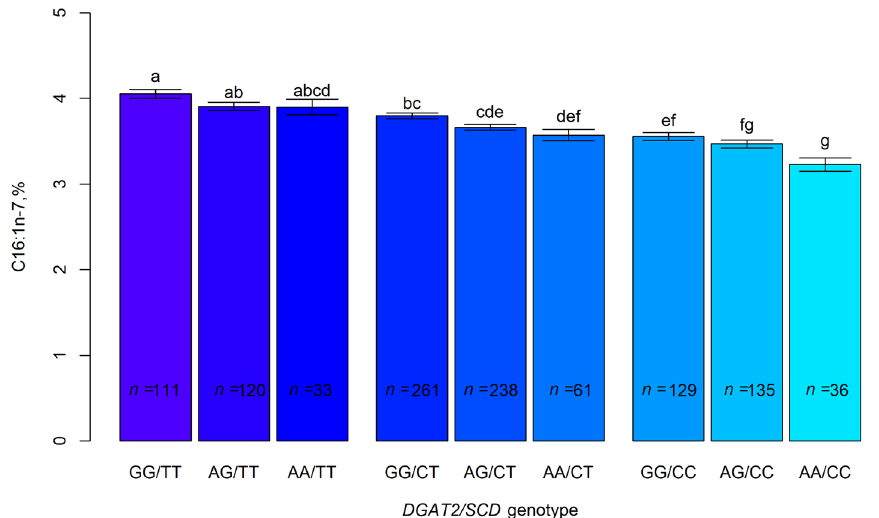
Figure 4. Effect of DGAT2 by SCD genotype on palmitoleic acid (C16:1n-7) in muscle gluteus medius . Numbers in boxes indicate the number of pigs used per genotype ( n ). Error bars represent standard errors. Columns lacking a common letter differ (P <